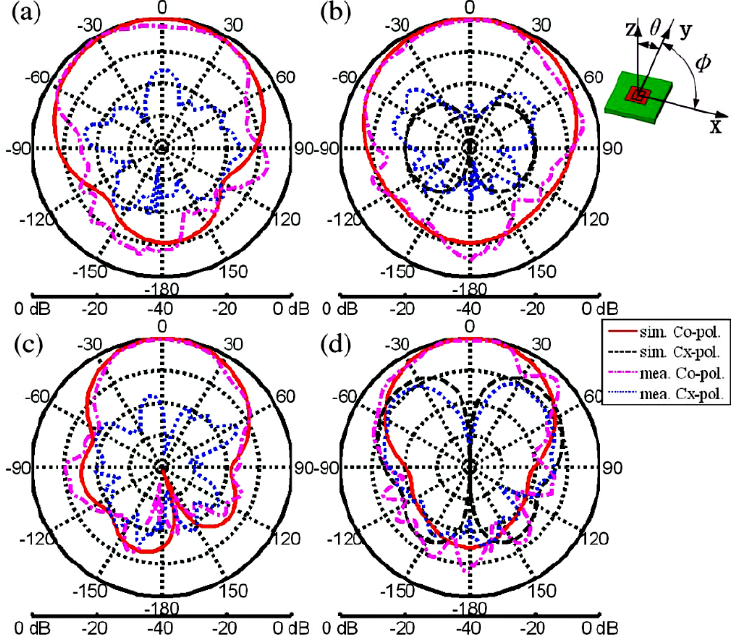
Figure 5. Simulated and measured radiation patterns in the ( a ) lower band in-plane, ( b ) upper band in-plane, ( c ) lower band in-plane, and ( d ) upper band in-plane [57].